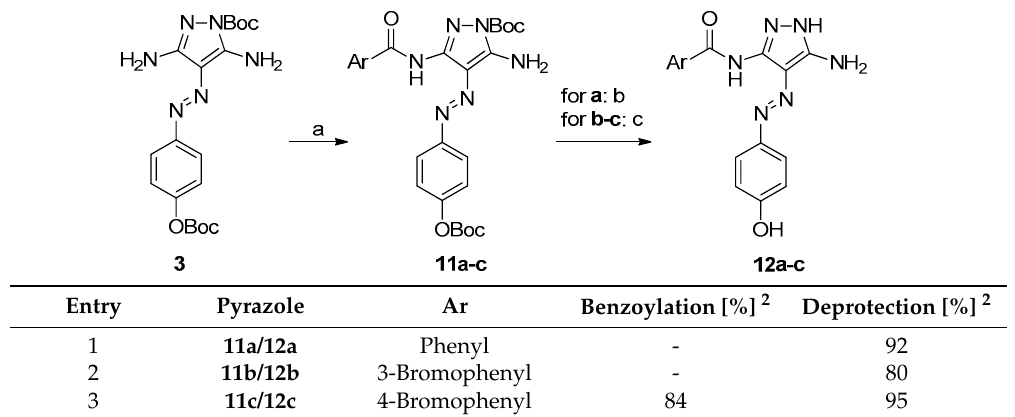
Table 1. Benzoylation of pyrazole 3 and subsequent deprotection 1 .